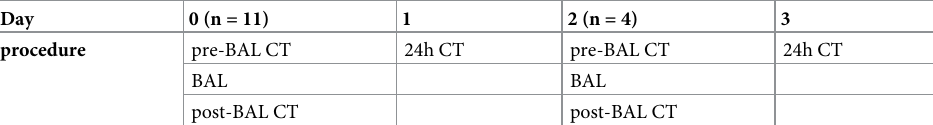
Table 2. Timeline of the procedures in the infected animals ( < 10 dpi) including the additional procedures in 4 infected animals.